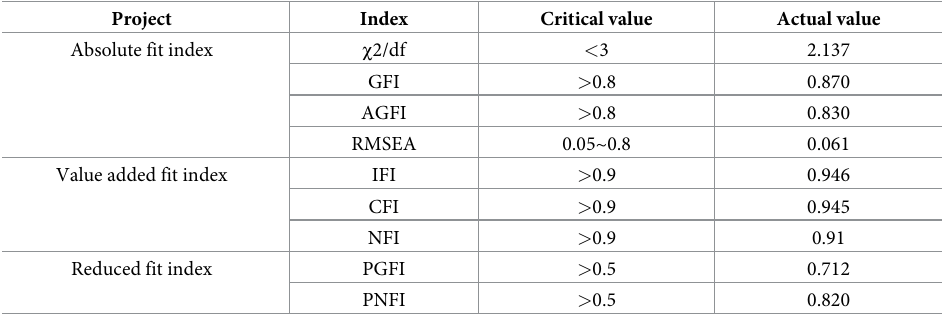
Table 13. Test value of model